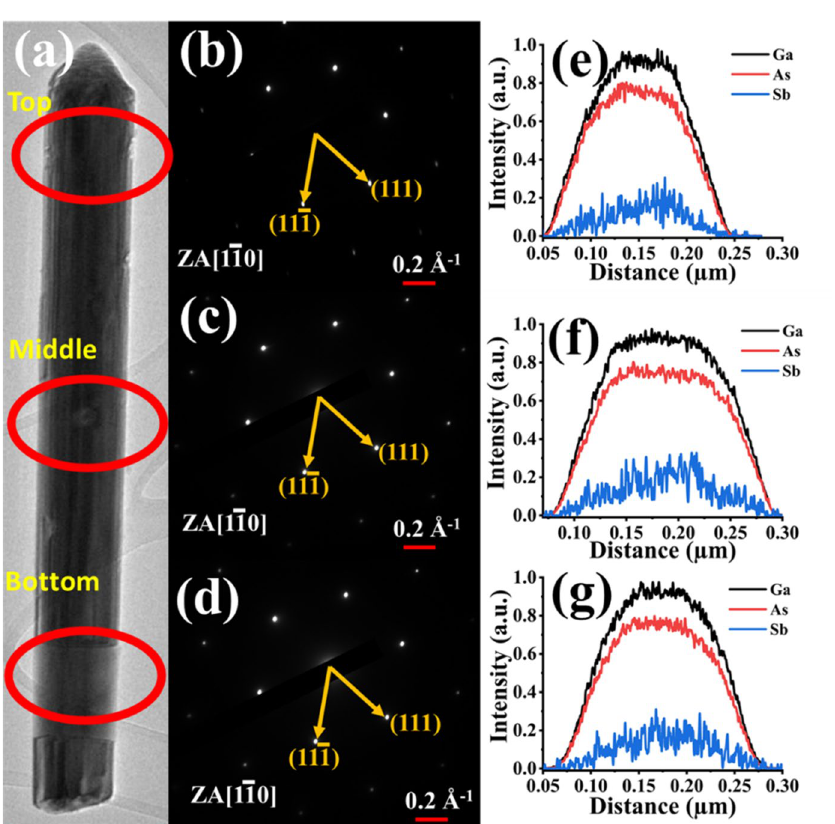
Figure 4. ( a ) Bright-field TEM image for dilute nitride NW, ( b – d ) selected area electron diffraction (SAED) for the top, middle, and bottom segments of the NW, and ( e – g ) energy dispersive X-ray spectroscopy for the corresponding NW